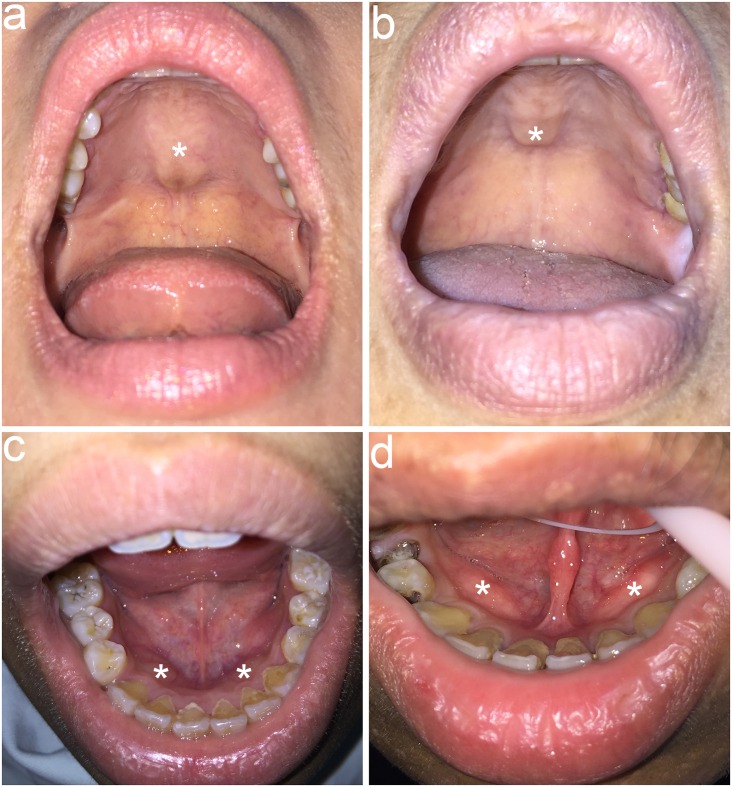
a, b. Torus palatinus. Intraoral view of two peritoneal dialysis patients with a flat torus palatinus (asterisk), which is an exophytic bony mass that arises along the midline of the hard palate. c, d. Torus mandibularis. Intraoral view of two peritoneal dialysis patients with a symmetrical lobular torus mandibularis (asterisk), which is an exophytic bony mass that arises along the lingual aspect of the mandible. Heavy dental calculus accumulating at cervical portion of teeth was also found in most patients.